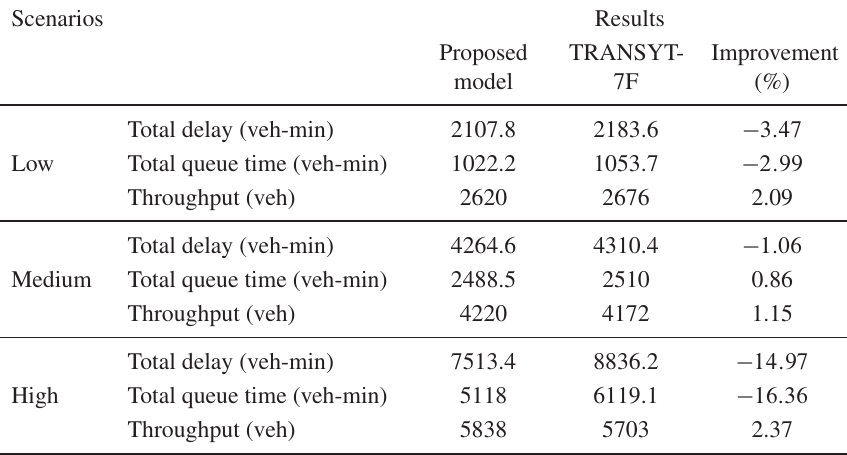
Table 3. Simulation